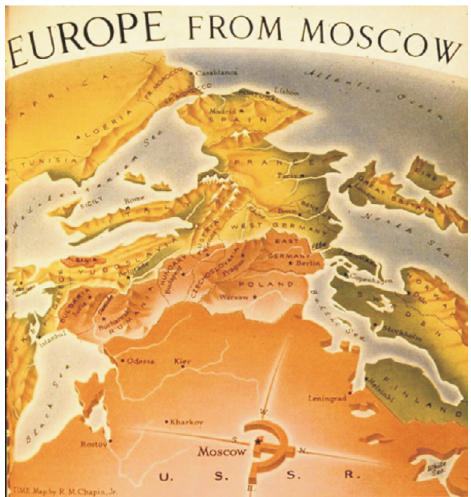
Fig. 15. Map called Europe from Moscow published by R. M. Chapin, Jr. in the journal “Time” March 10, 1952